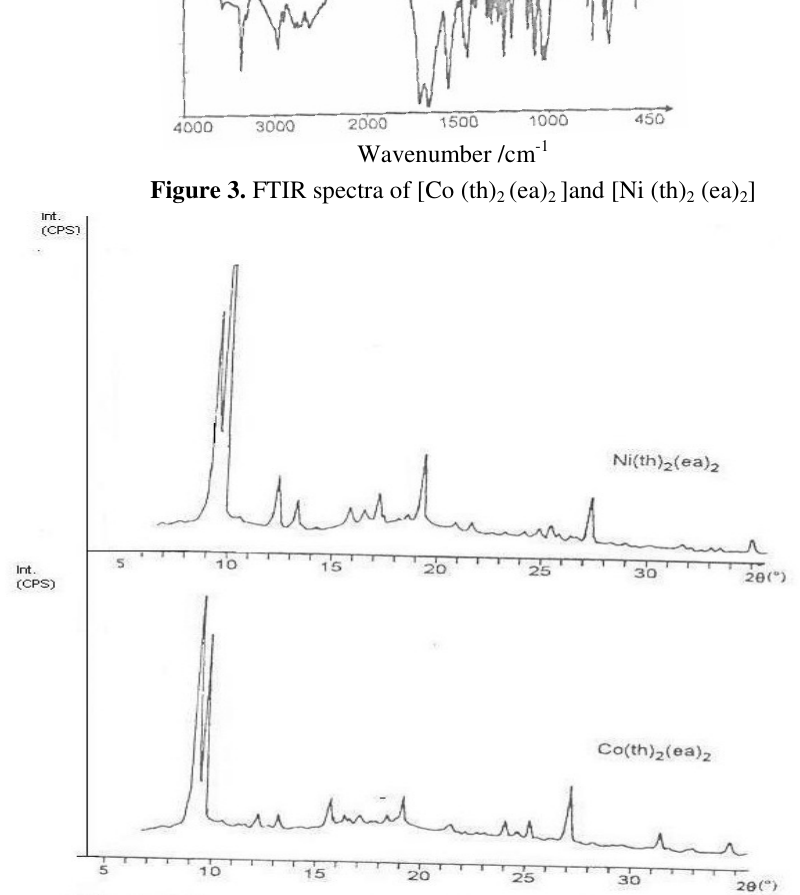
Figure 4 . XRD patterns of [Co(th)